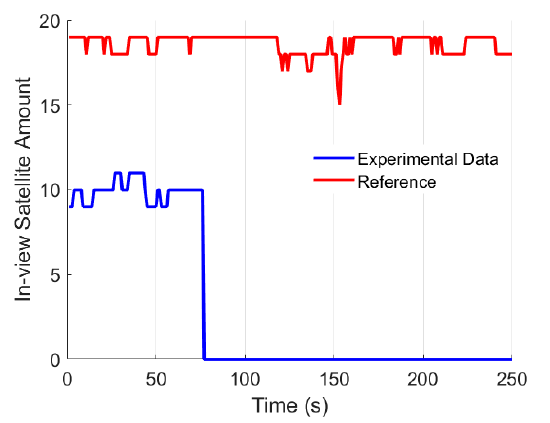
Figure 9. Satellite’s amount